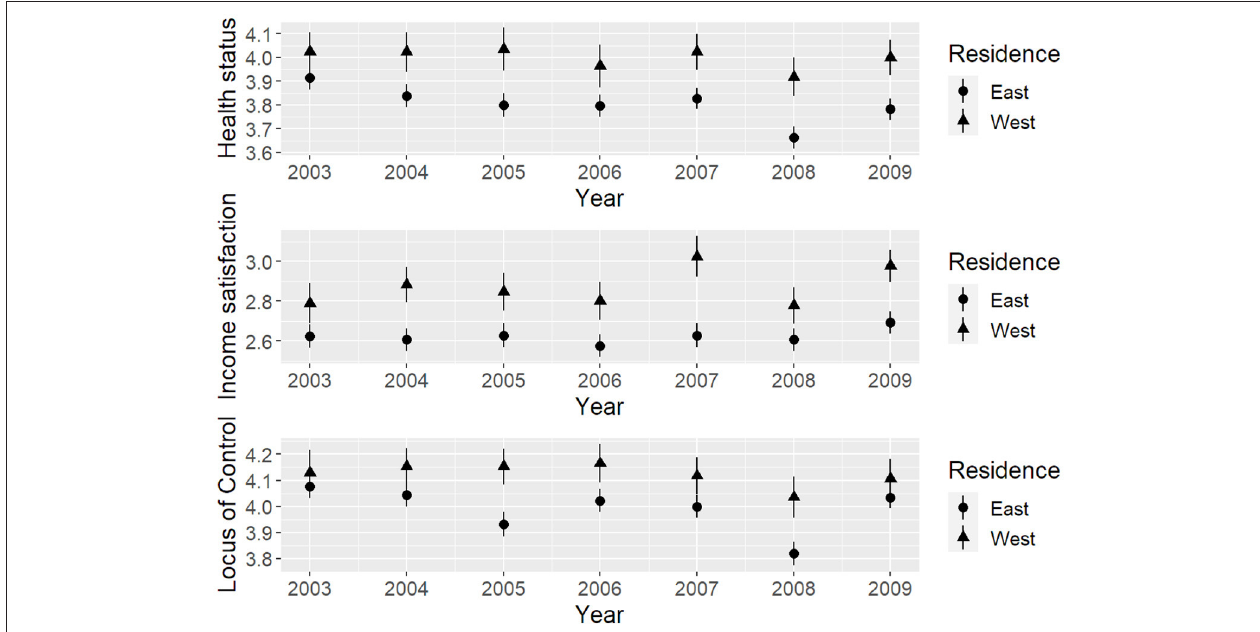
FIGURE 2 | Observed mean scores of subjective health status, satisfaction with income, and locus of control for individuals in East- and West-Germany across time.